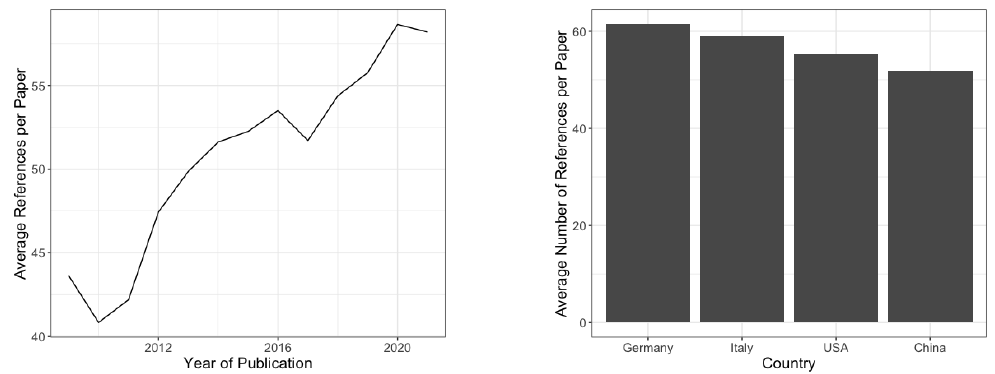
Figure 14. Average number of references per paper shown per year ( left ) and for selected countries ( right ) for papers published in Remote Sensing from 2009 to